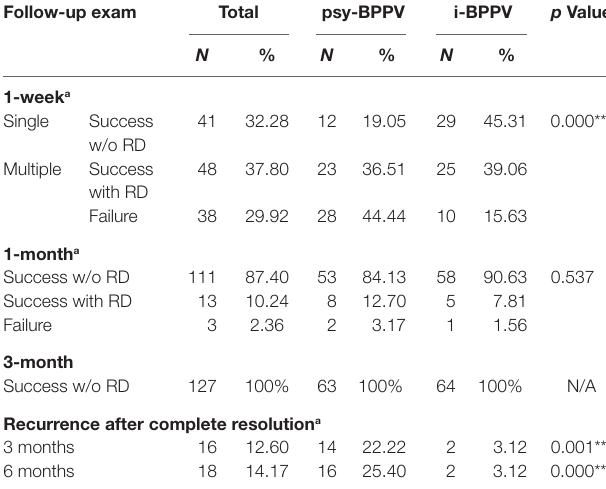
TaBle 2 | Treatment outcomes of BPPV